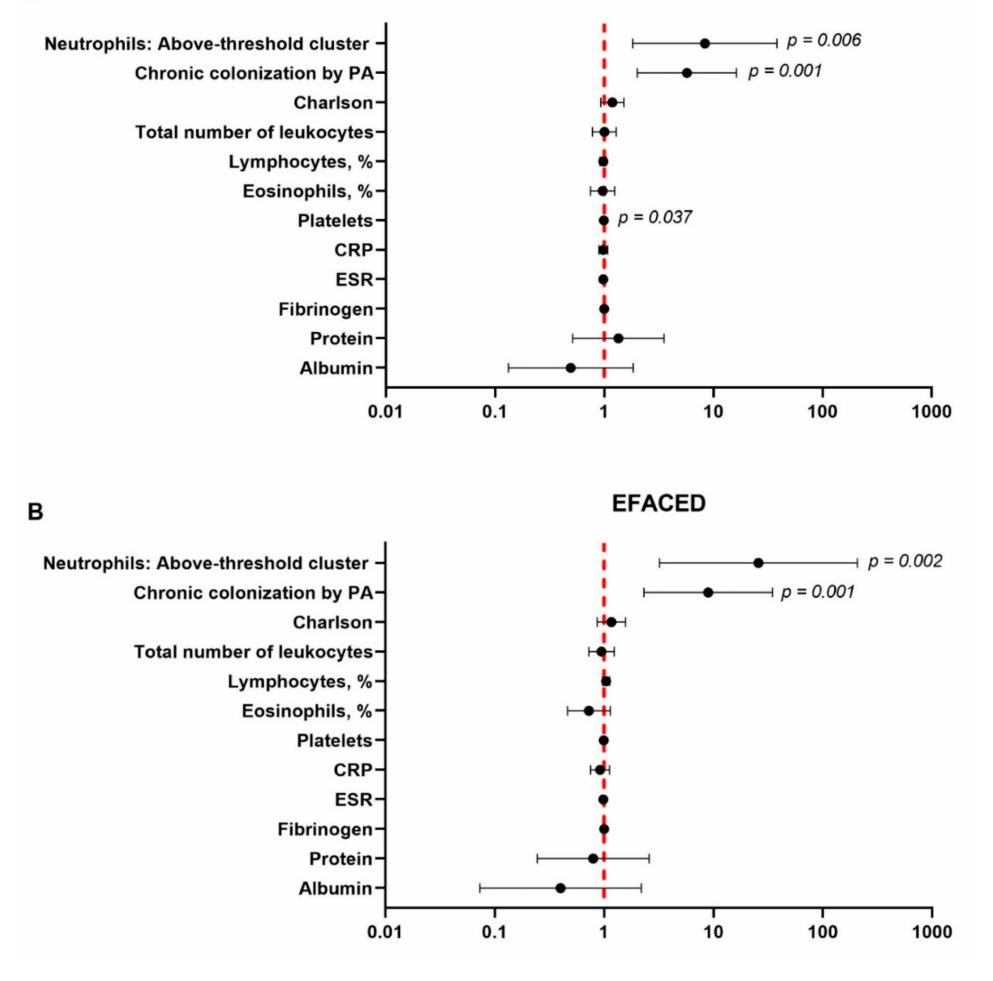
Figure 5. The independent association of dichotomized neutrophils with the values of ( A ) FACED and ( B ) EFACED. A multivariate regression analysis was used to perform the analysis. The confidence intervals and statistical significance are represented in the figure panel. The odds ratio is represented as black dots. The model was adjusted by the chronic colonization by Pseudomonas aeruginosa , Charlson index, the total number of leukocytes, the percentage of lymphocytes and eosinophils, the number of platelets, and C-reactive protein (CRP), fibrinogen, protein and albumin levels, and erythrocyte sedimentation rate